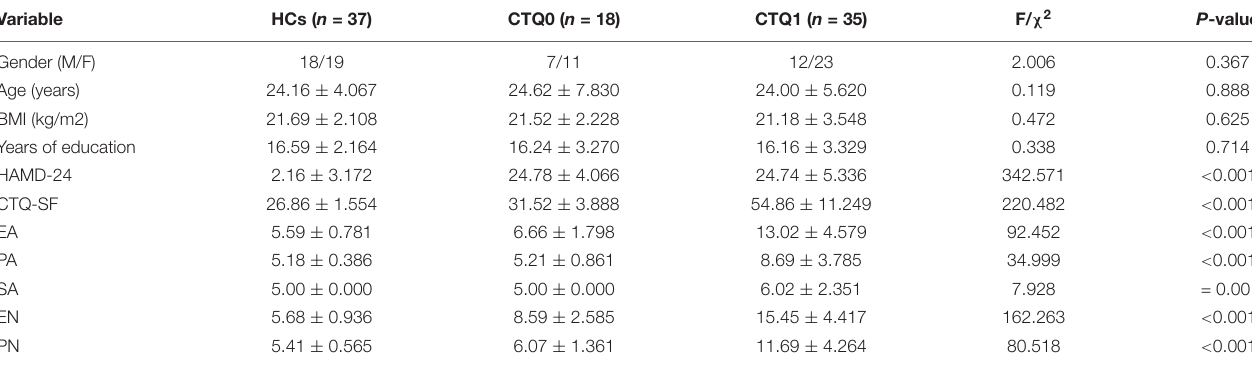
TABLE 1 | Clinical and demographic characteristics of the HC, CTQ0, and CTQ1 groups.